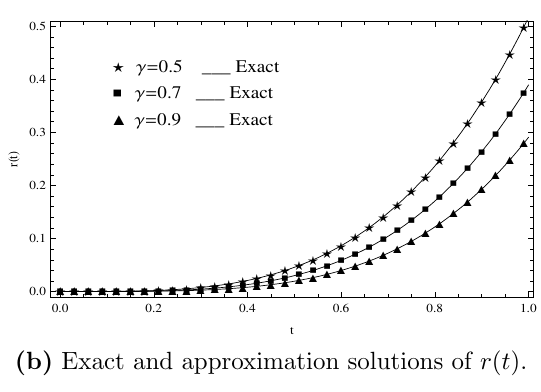
Figure 2. Absolute errors of m ( t ) and r ( t ) for N = 10 and γ = 1 for Example 1.